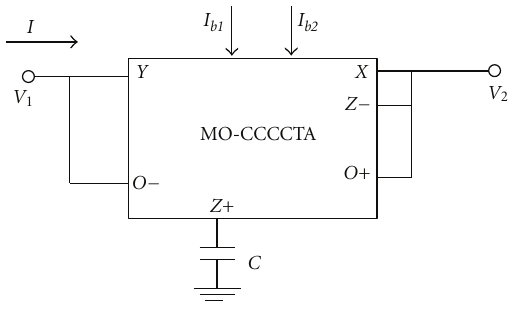
Figure 3: Proposed floating positive inductance.